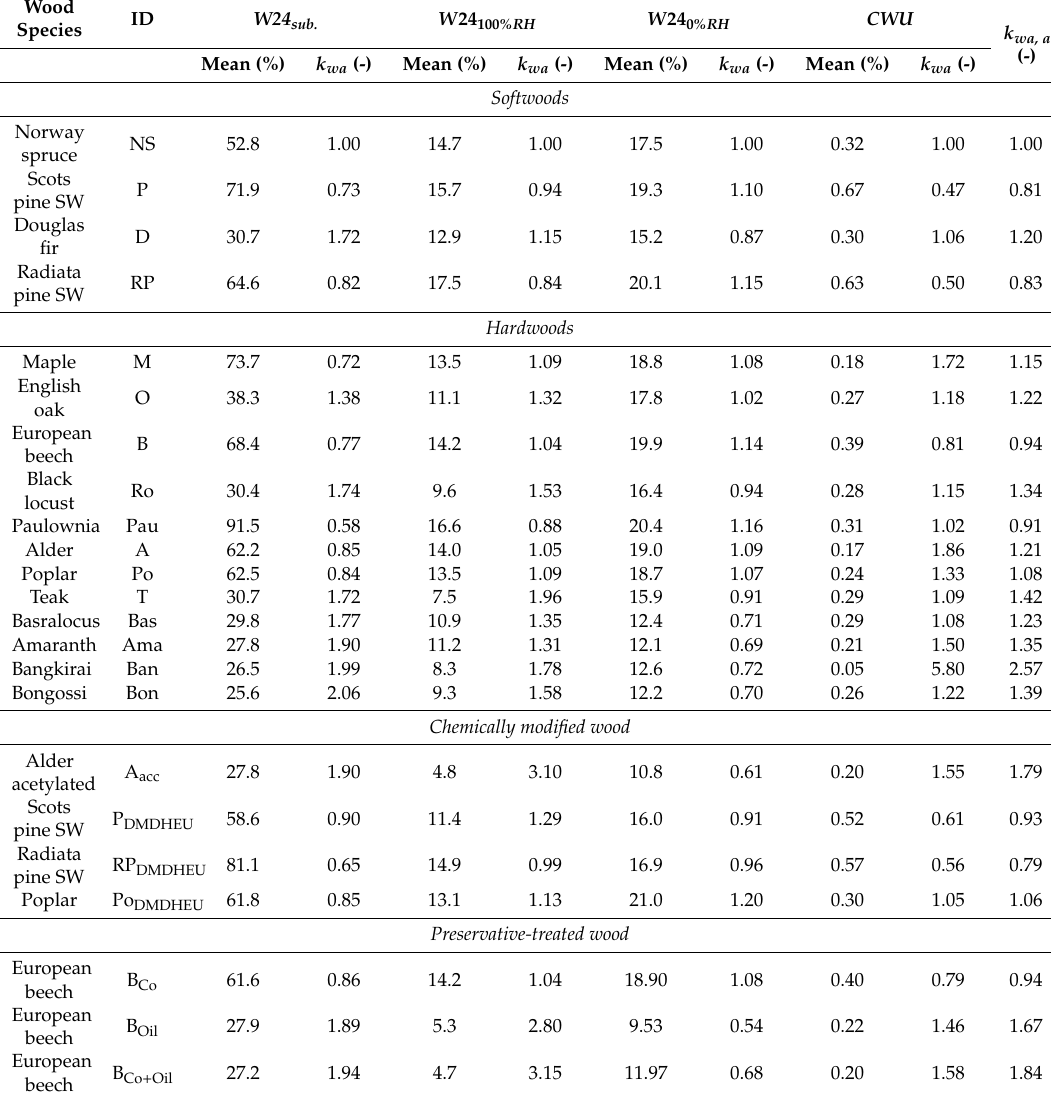
Table 1. Moisture content of 100 (ax.) × 10 × 5 mm 3 specimens after exposure to di ff erent moistening and drying regimes during 24 h